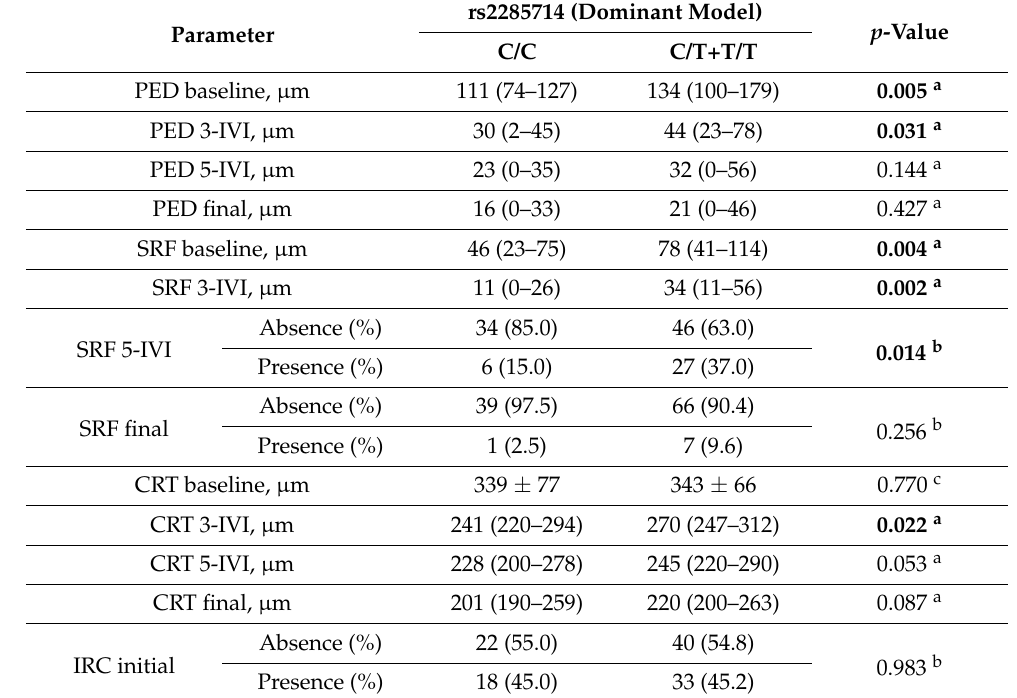
Table 7. Analysis of the OCT biomarkers depending on the rs2285714 (C/C vs. C/T+T/T) T allele